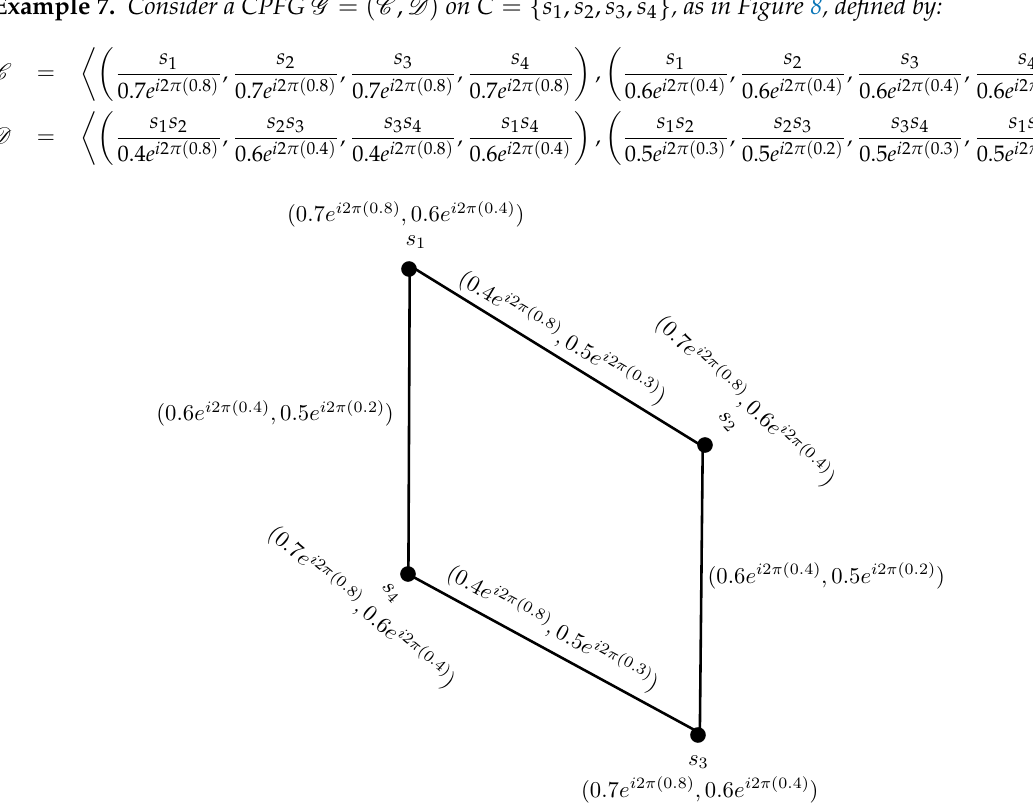
Figure 8. ( 1.7 e i 2 π ( 2.0 ) ,1.6 e i 2 π ( 0.9 ) ) -totally regular complex Pythagorean fuzzy Figure 8: (1 . 7 e i 2 π (2 . 0) , 1 . 6 e i 2 π (0 . 9) )-totally regular complex Pythagorean fuzzy graph.